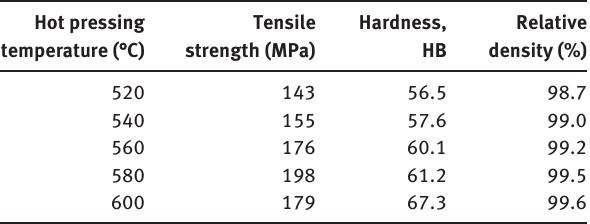
Table 1 The variation in tensile strength, hardness and relative density of composite in different vacuum hot pressing